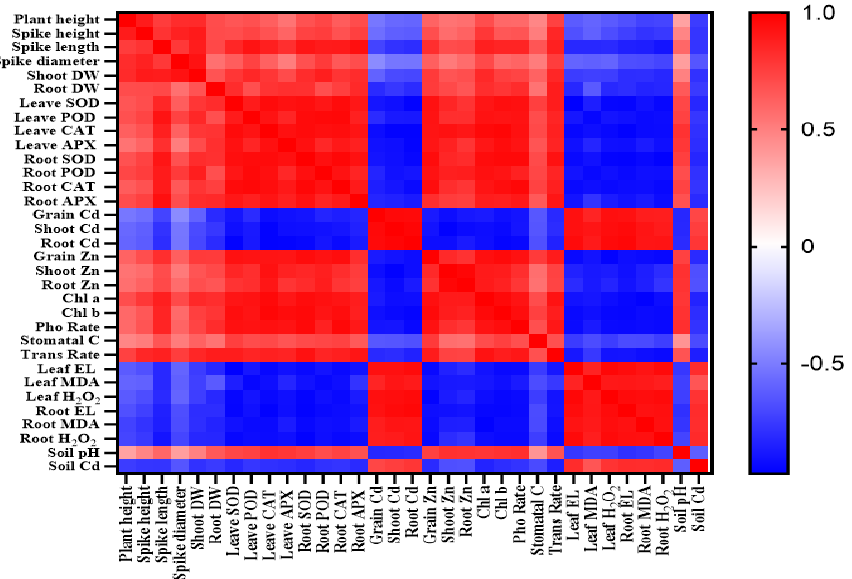
Figure 5. Correlations between different parameters. DW: dry weight; EL: electrolyte leakage; H 2 O 2 : hydrogen peroxide; MDA: malondialdehyde; SOD: superoxide dismutase; POD: peroxidase. All the above indexes showed extremely significant correlations at the 0.01 level.